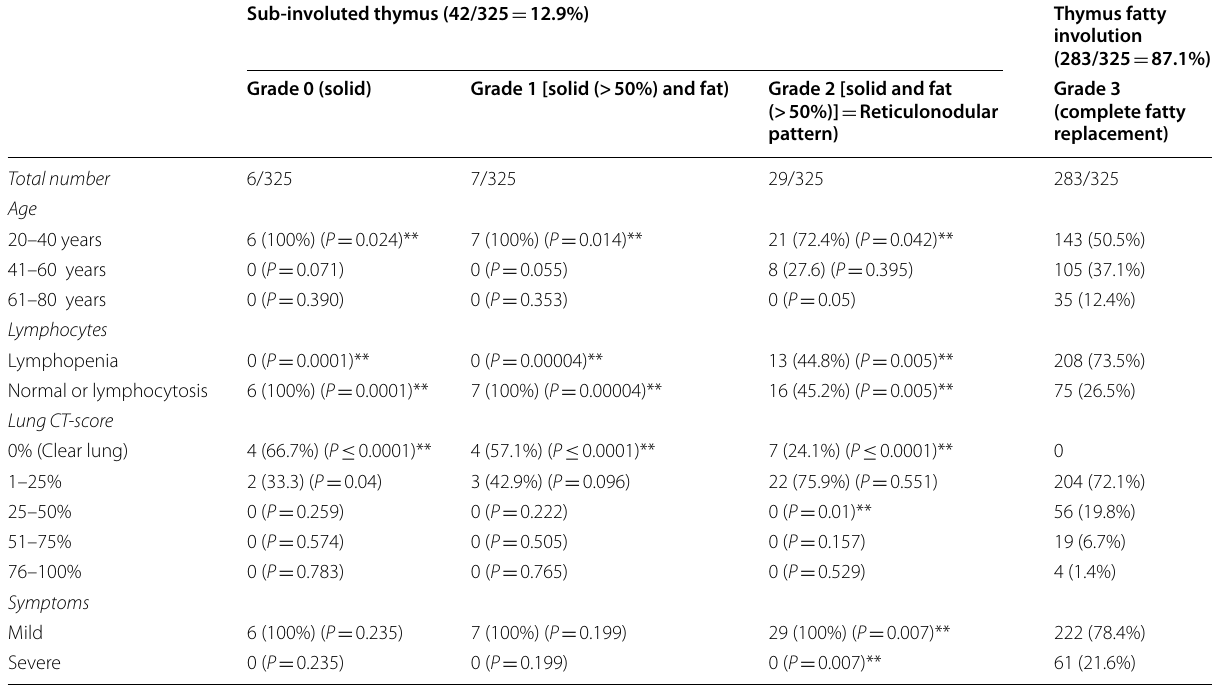
**Correlation is significant at the 0.05 level